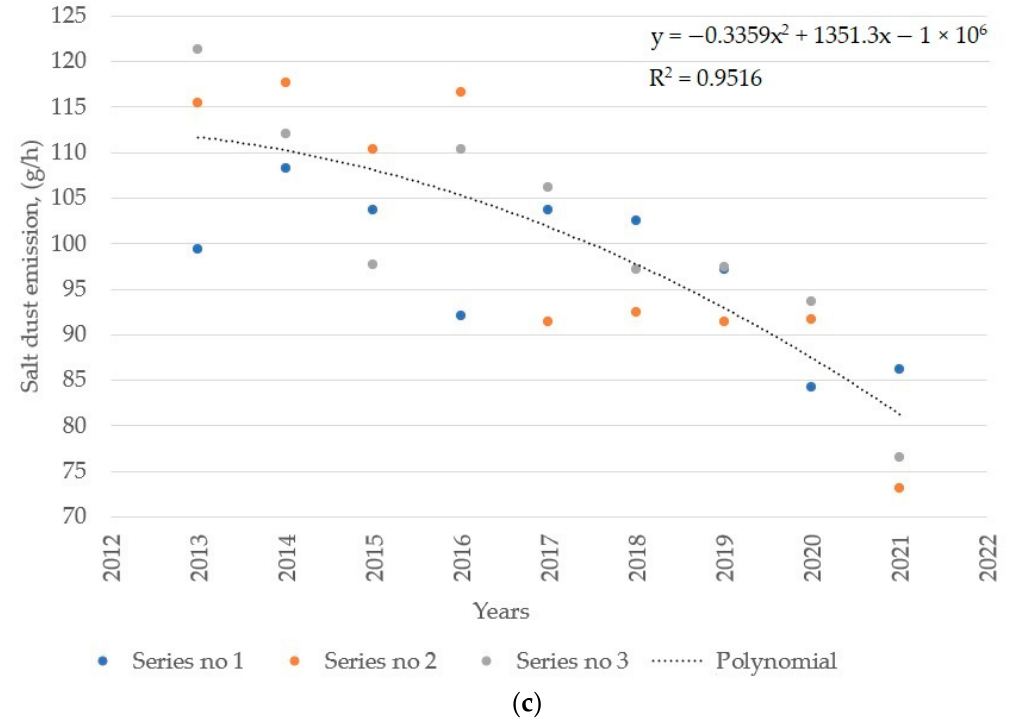
Figure 6. Salt-dust emissions in the Wieliczka Salt Mine in the years: ( a ) 2004–2006; ( b ) 2007–2012; ( c ) 2013–2021.